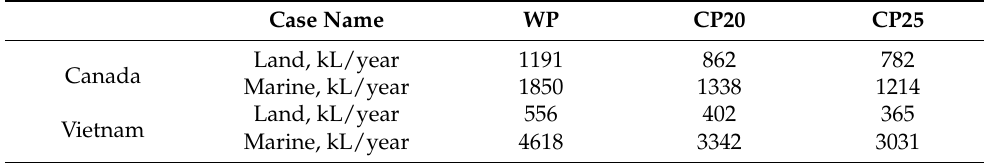
Table 5. Energy consumption during